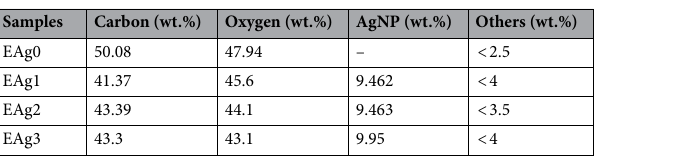
Table 3. Numerical values of EDX analysis for control and nanosilver-coated sisal/cotton interwoven fabrics.